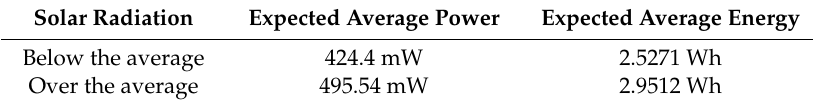
Table 5. TEG expected power and energy based on temperature gradient measurements.